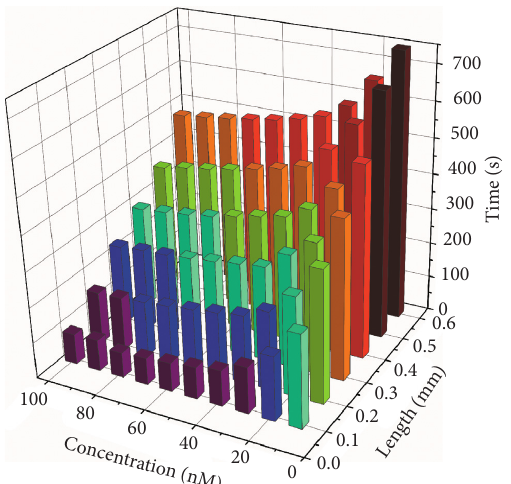
Figure 13: The variation of lysis time over different tPA con- centrations and various clot sizes.